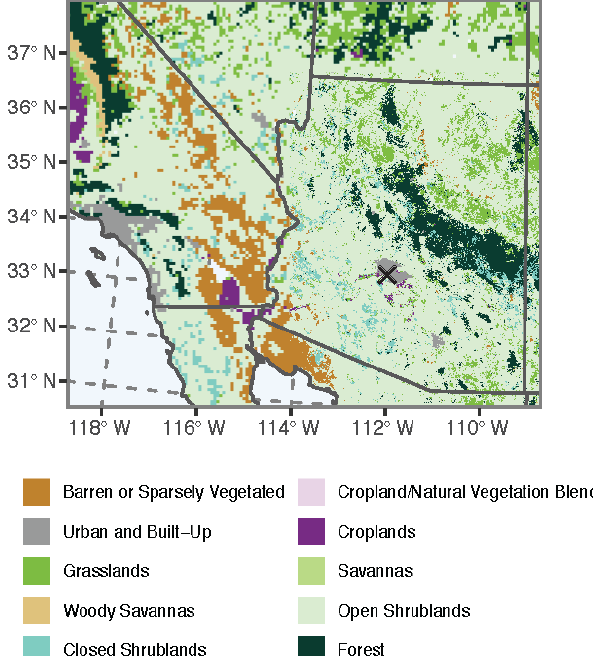
Figure 3. Prescribed land use categories assumed for the model do- main. The black × marks the location of Phoenix,